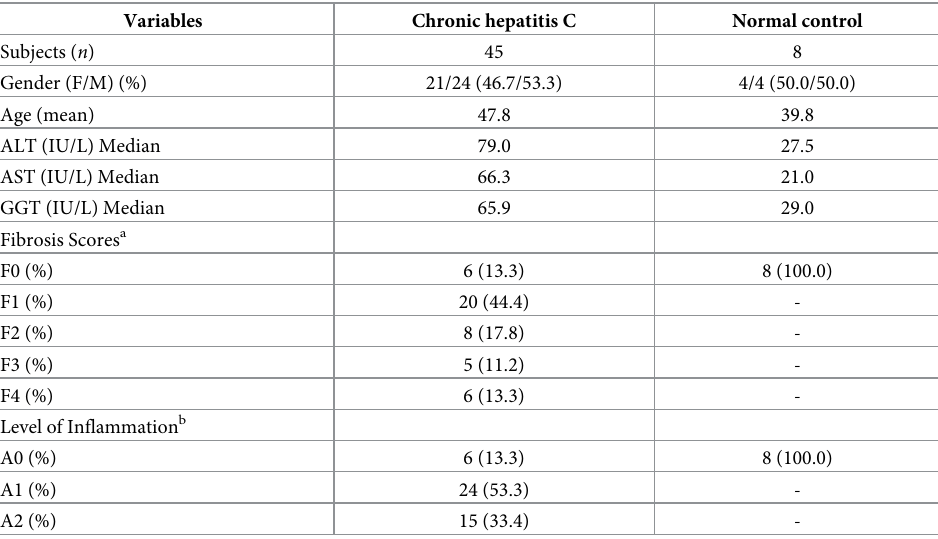
Table 1. Clinical, biochemical, and histopathological information on the study population. Variables Chronic hepatitis C Normal